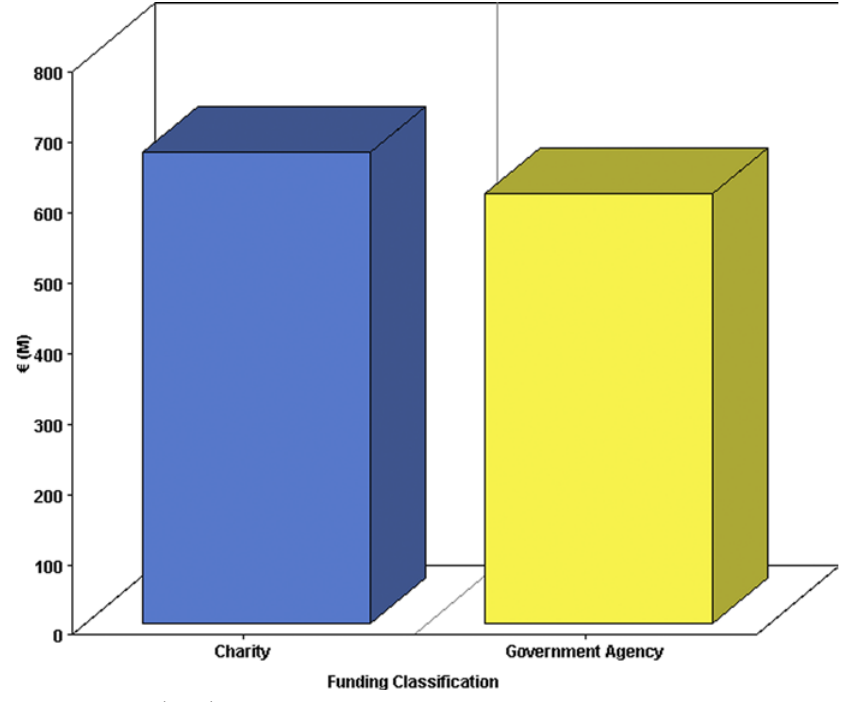
DOI: 10.1371/journal.pmed.0030267.g003 Figure 3. Direct Cancer Research Spending by Type of Funding